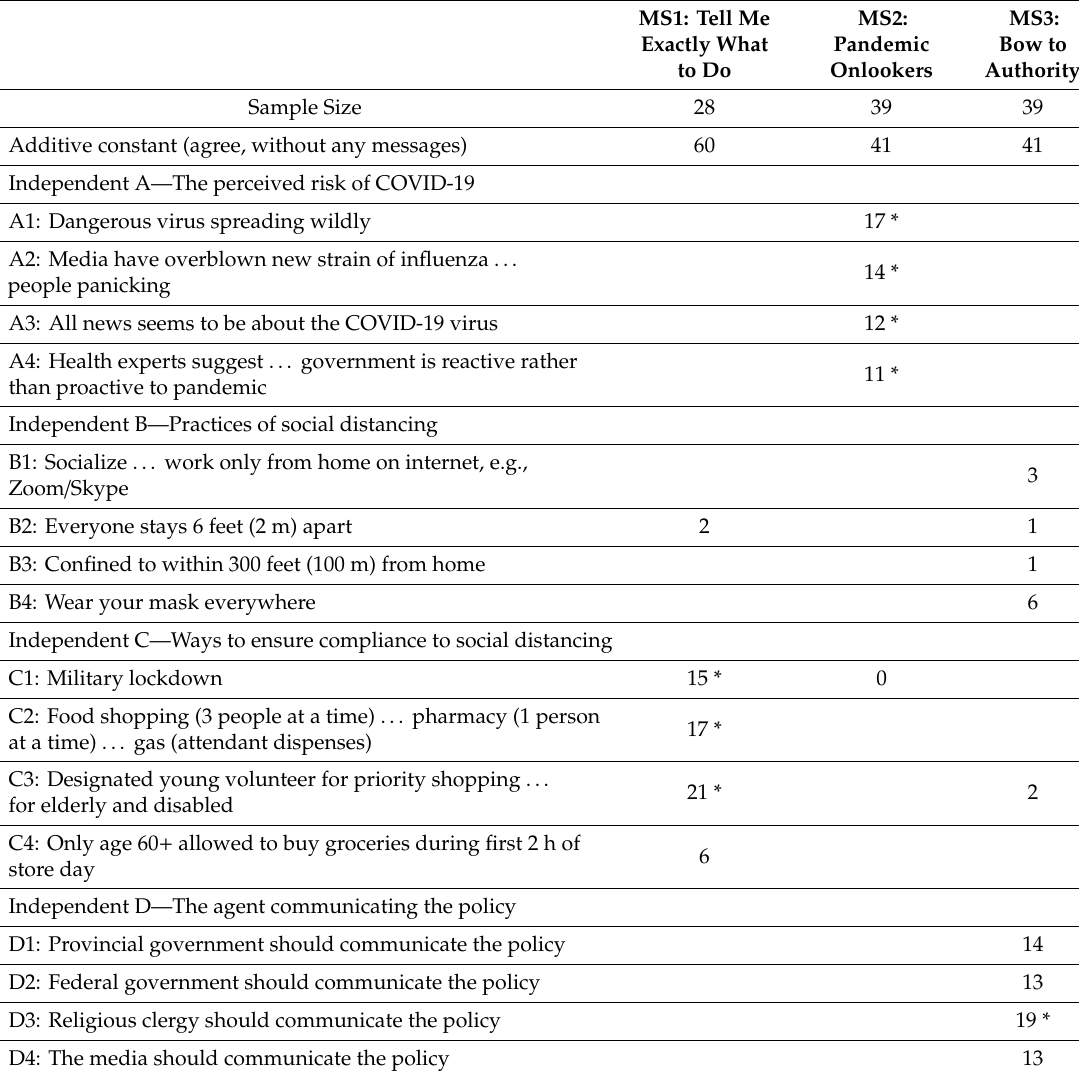
Table 3. Three mindset segments (MS) for Canada.